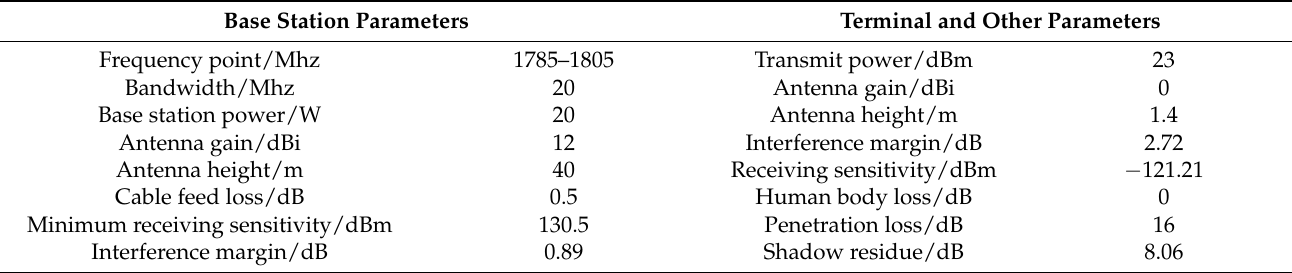
Table 6. System parameter